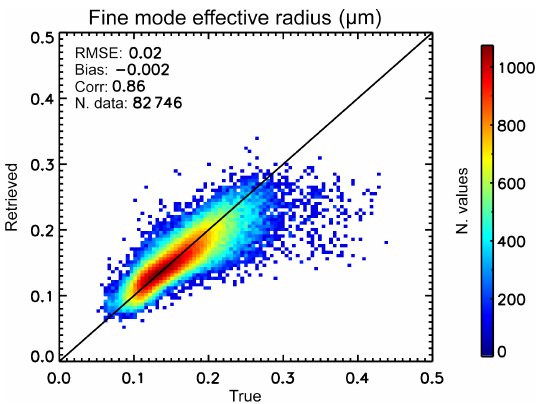
Figure 5. Neural network retrieved versus true fine-mode effective radius from synthetic test data. Only cases with fine-mode AOT larger than 0.1 are shown.